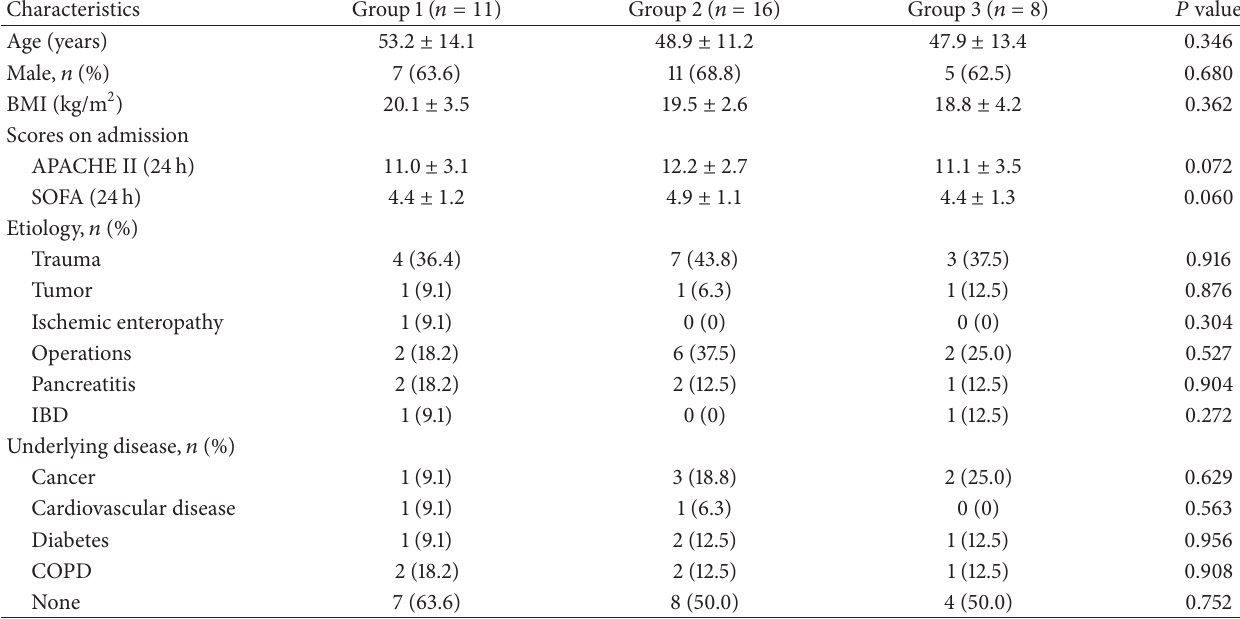
Table 2: Demographics and clinical characteristics of the fistuloclysis